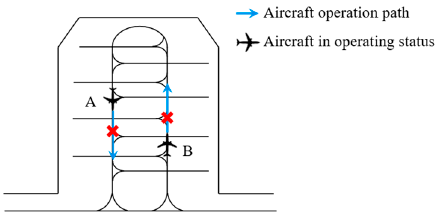
Figure 3. Intersection Taxiing Diagram of Arrival and Departure Aircraft. The intersection taxiing of departure aircraft A and arrival aircraft B is not allowed.